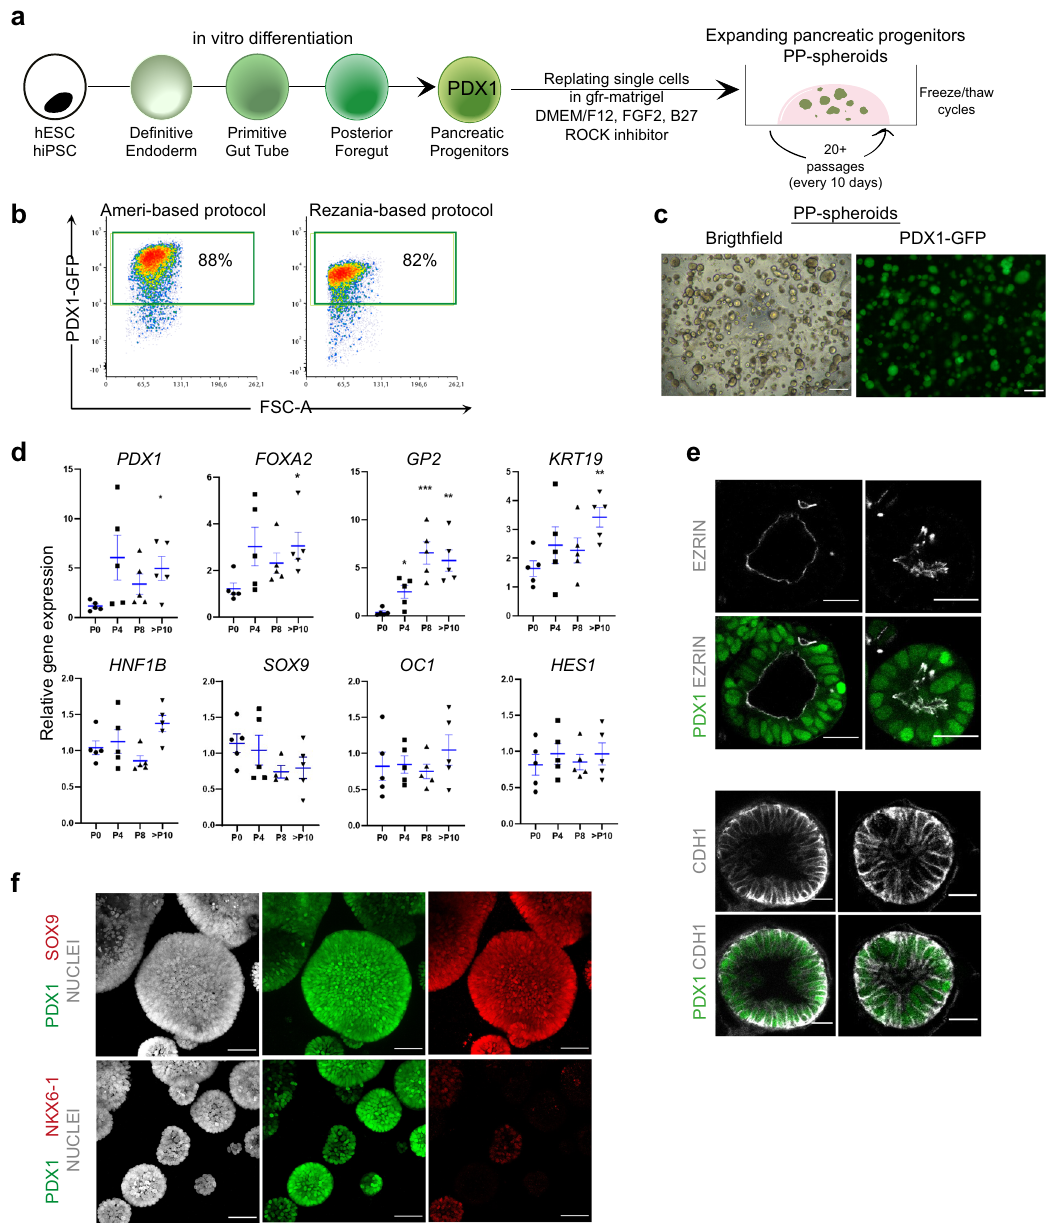
Fig. 2 A minimal culture system allowing for long-term culture of human spheroids harboring pancreatic progenitors. a Starting from hiPSC or hESC lines, we performed stepwise differentiation until the pancreatic progenitor stage (S4d8 for Ameri protocol and S4d3 for Rezania protocol, PDX1 + ), at which point cells were re-plated in 3D Matrigel with FGF2, B27, and ROCK inhibitor Y-27632 supplementation. In these conditions, PP-spheroids formed and could be passaged every 10 days for at least 20 passages, including going through freeze/thaw cycles. b Prior to re-plating, the percentage of PDX1 cells was measured to ensure a successful differentiation. Representative intracellular fl ow cytometry analysis for PDX1 at the end of stage 4 of the protocol based on Ameri et al. 45 and the protocol based on Rezania et al. 16 . c PP-spheroids at day 10 in culture, scale bar = 250 µ m. d Expression of pancreatic progenitor genes in PP-spheroids at different passages ( N = 5), data shown as mean ± SEM. * P < 0.05, ** P < 0.01, *** P < 0.001. P values were determined by two-sided Mann – Whitney test. e Optical section of whole-mount images showing PDX1, EZRIN, and CDH1 staining, scale bar = 25 µ m. f Z-stack projection of whole-mount images showing PDX1, SOX9, and NKX6-1 staining, scale bar = 50 µ m. Images shown in c , e , and f are representative of over ten independent experiments. See also Supplementary Fig. cell cycle annotated genes 47 . This is likely to be symptomatic of the Rezania et al. 16 protocols were overall very similar. A few contact inhibition in 2D. We also observed that while cells differences were however identi fi ed when comparing only the two produced using different protocols distributed similarly in the populations in 2D, the most notable being higher expression of global UMAP, early spontaneous differentiation into the endo- ID1 and IGFBP7 in cells differentiated with the Ameri et al. 45 crine path was seen only in the Rezania et al. 16 protocol protocol, and higher expression of the liver markers FGB and (Supplementary Fig. 3g), likely a result of BMP inhibition 18,48 . APOC3 in cells differentiated with the Rezania et al. 16 protocol The EPs of progenitors arising from either the Ameri et al. 45 or (Supplementary Fig. 3f), possibly due to the lower expression of